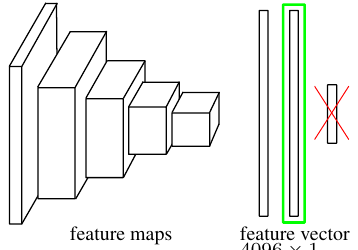
Figure 7. Changes in the VGGNet to use the output of the last layer as feature vector. The Classification layer is removed and the penultimate layer with the size of 4096 × 1 is used as feature vector.